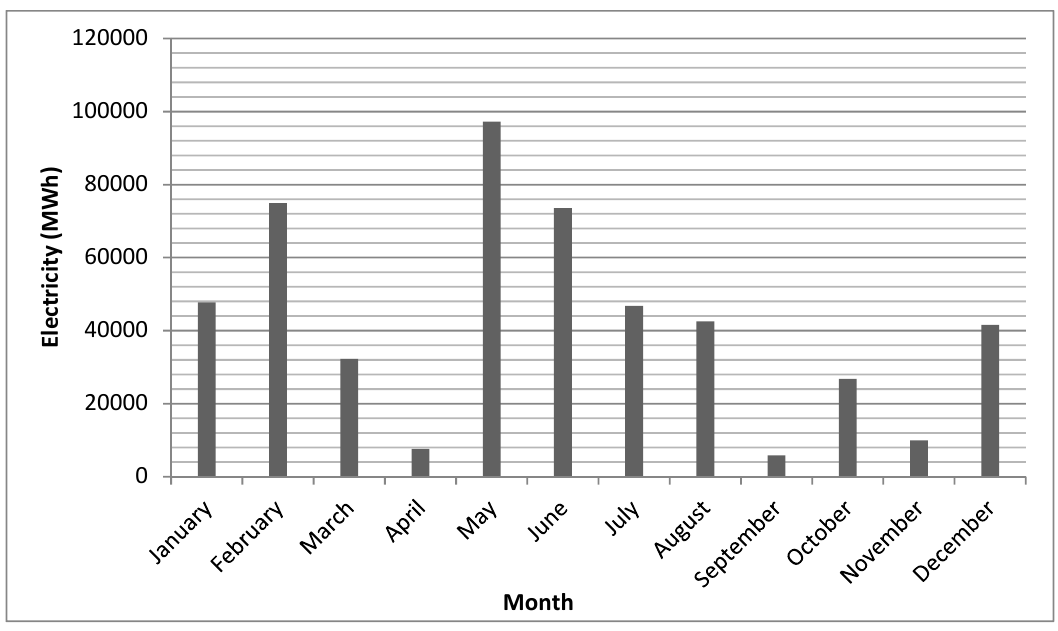
Figure 3. Monthly power production schedules at the AGS. The bars represent actual monthly power production in 2010 at the AGS to meet electricity demands